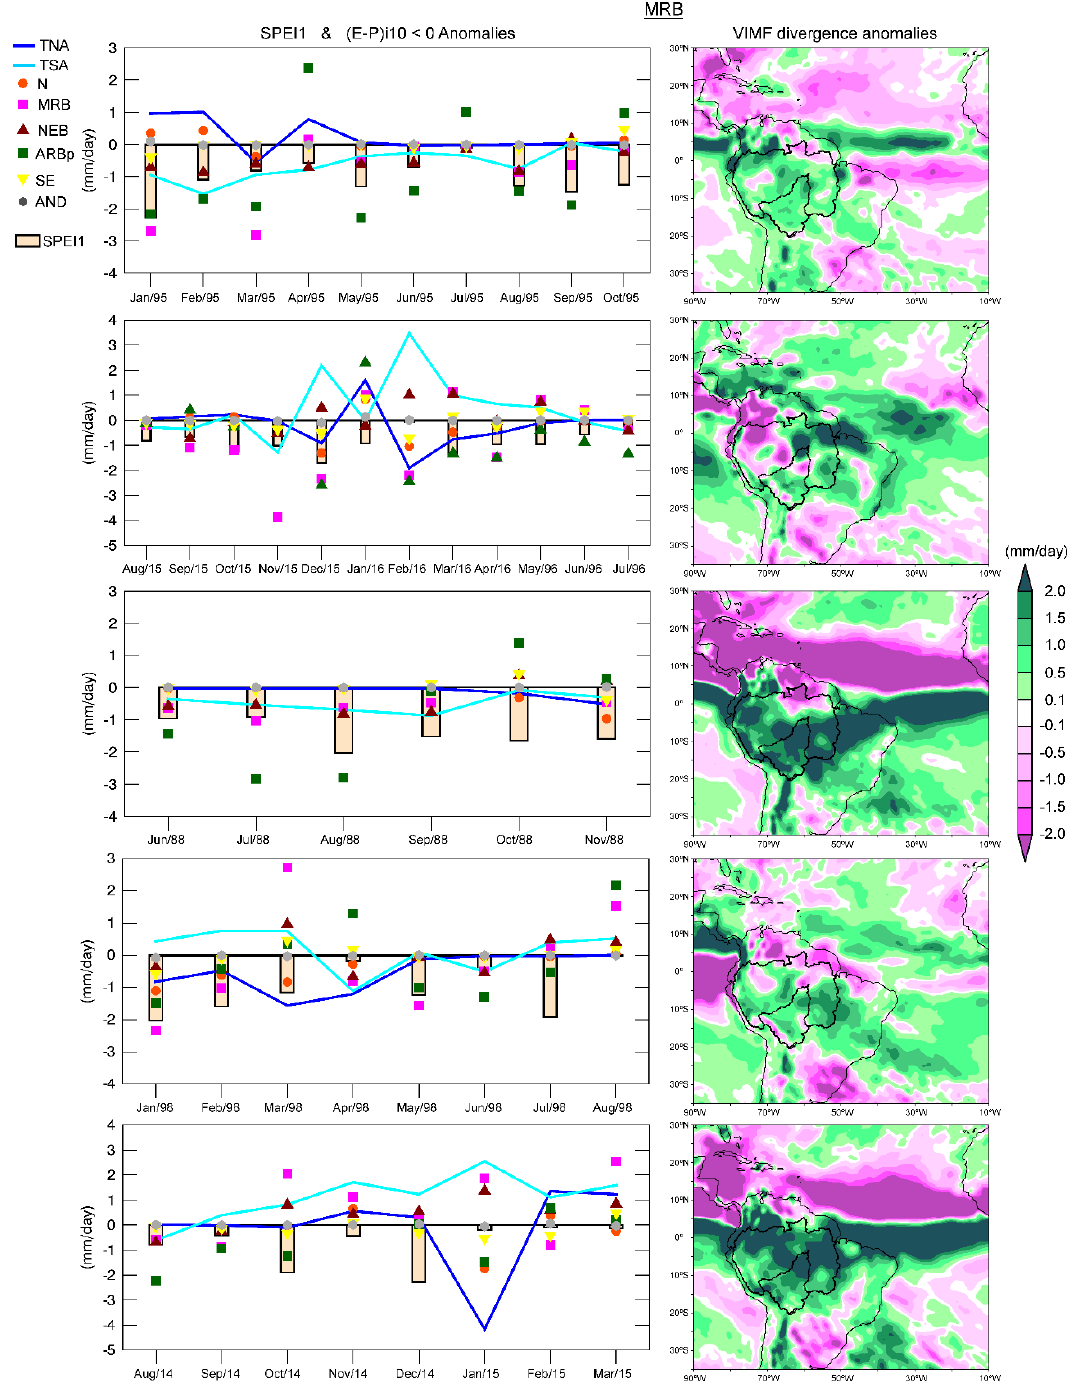
Figure 13. The SPEI1 and monthly anomalies of | (E – P)i10 < 0| during the most severe dry episodes (left panel) in the MRB (ordered as in Table 3) and VIMF divergence anomalies for each episode (right panel).